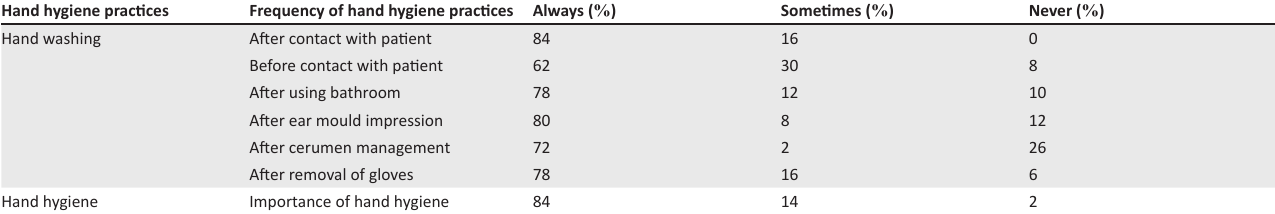
TABLE 2: Hand washing practices of respondents in clinical settings. Hand hygiene